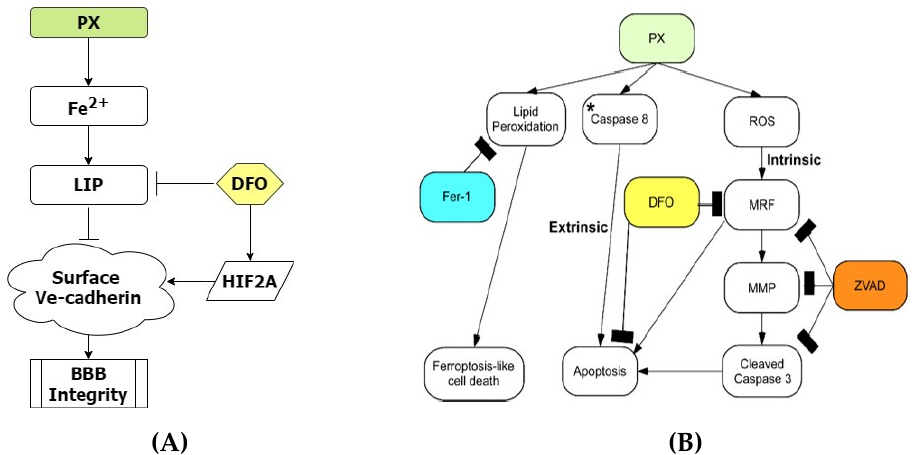
Figure 6. BBB integrity is regulated by the iron dependent HIF2 α -Ve cadherin axis. ( A ) Flowchart elucidating the molecular pathways that regulate BBB integrity in our model. Upon insult the labile iron pool is significantly increased, resulting in damage to the BBB integrity. DFO rescues BBB functionality by inducing the expression of HIF2 α that results in the restoration of Ve-cadherin on the cell surface; ( B ) Flowchart elucidating the molecular pathways initiated in our model. * We have recently reported that inhibiting caspase-8 decreased apoptosis in our model [44]. PX, paraoxon; ZVAD, Z-VAD-FMK; Fer-1, Ferrostatin; MRF, mitochondrial ROS formation; MMP, mitochondrial membrane permeability; au, arbitrary units.